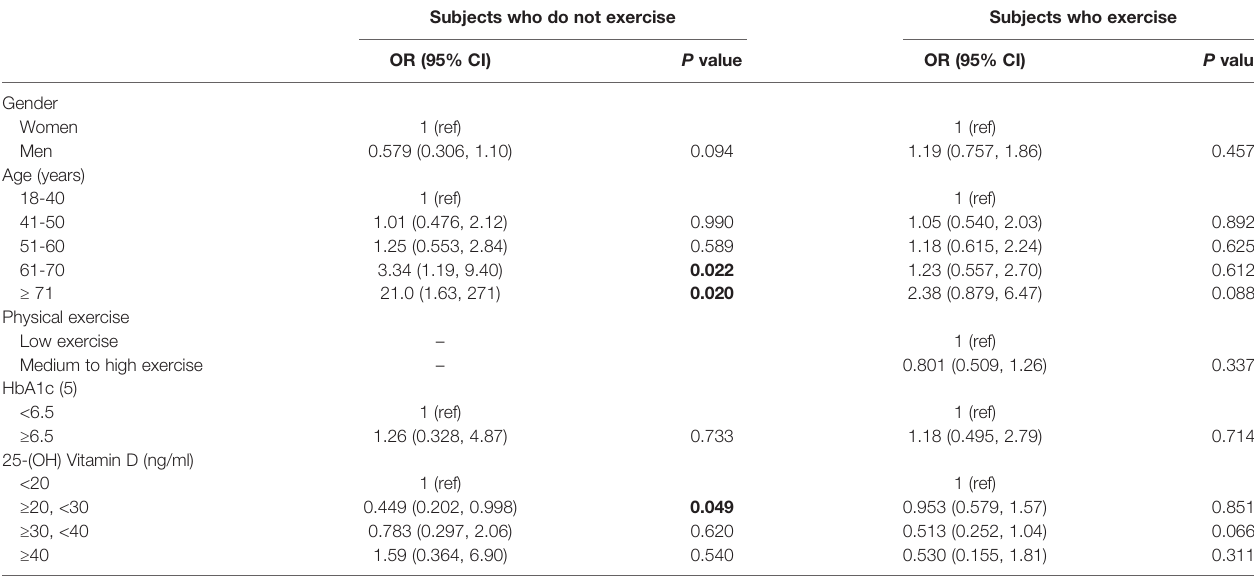
TABLE 3 | Factors associated with very low NKA < 100 pg/mL compared to normal NKA ≥ 500 pg/mL in subjects who do or do not exercise. Subjects who do not exercise Subjects who exercise OR (95% CI) P value OR (95% CI) P